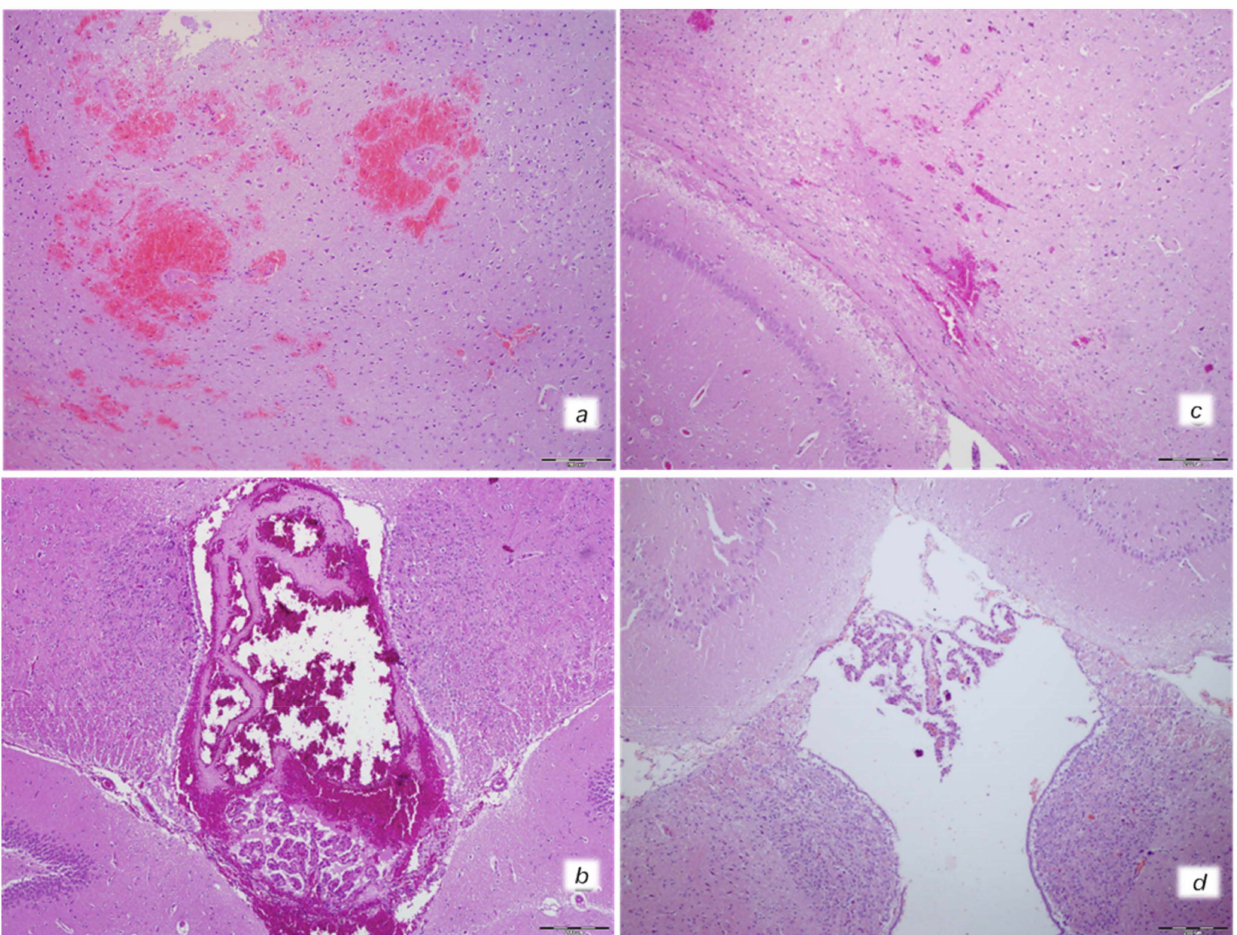
Figure 7. Neuropathological changes of cerebral area. Isoprenaline 75 mg/kg at 30 min after challenge. Control group ( a , b ). ( a ) Large areas of intracerebral hemorrhage. B. Intraventricular hemorrage in the 3rd ventricle. BPC 157 treated rats ( c , d ). ( c ) Minor intracerebral hemorrhage. ( d ) No hemorrhage in the 3rd ventricle. (HE; magnification 100 × ; scale bar 200 µ